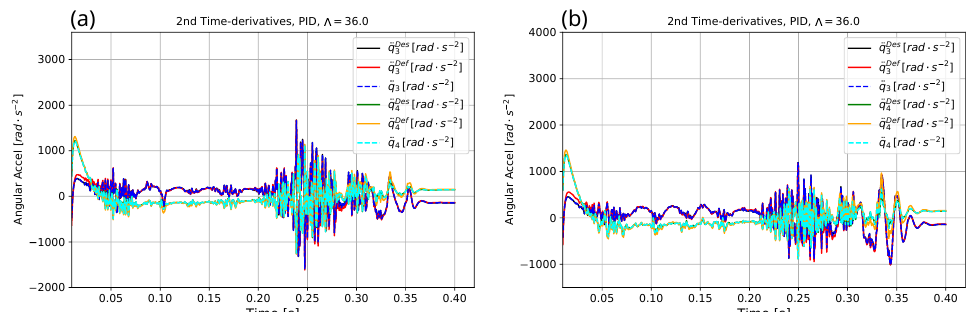
Figure 10. Second time derivatives without force limitation for the joint coordinates q 3 ( t ) and q 4 ( t ) without the initial transient. ( a ) For set 1. ( b ) For set 2. Adaptive Torque/Force, PID, =36.0